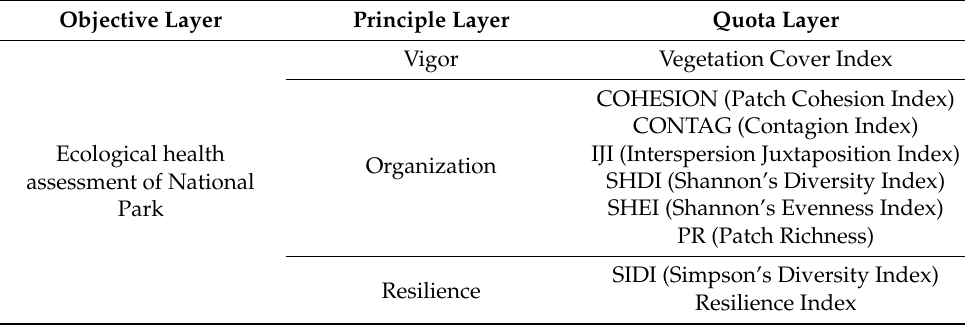
Table 3. Ecosystem health evaluation indicator system of Shennongjia National Park.